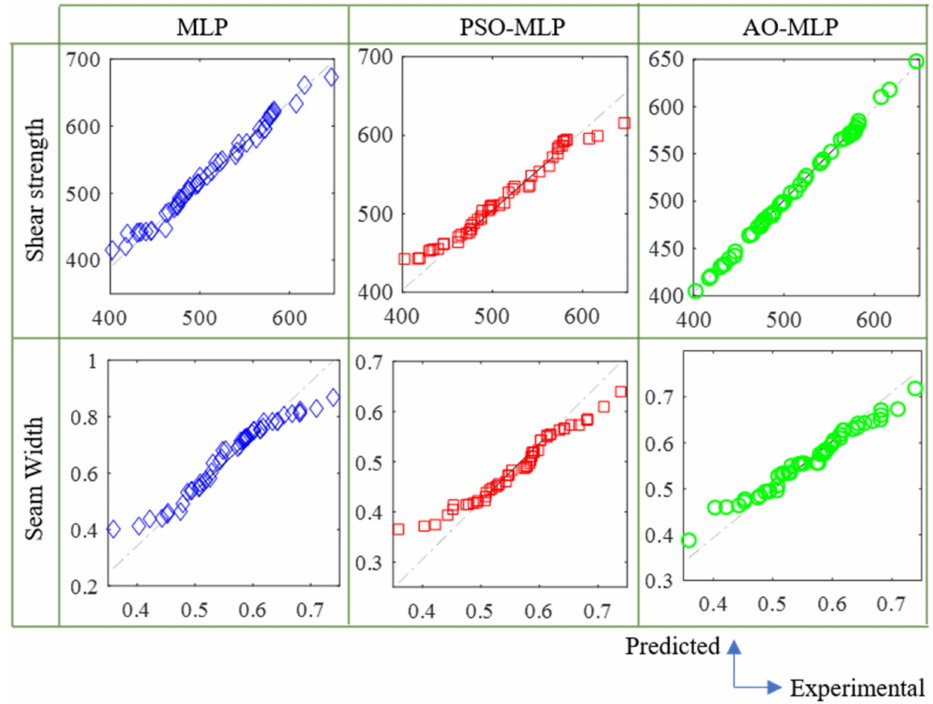
Figure 4. Q-Q plots of predicted data using MLP, PSO-MLP, and AO-MLP and target ones for shear strength and seam